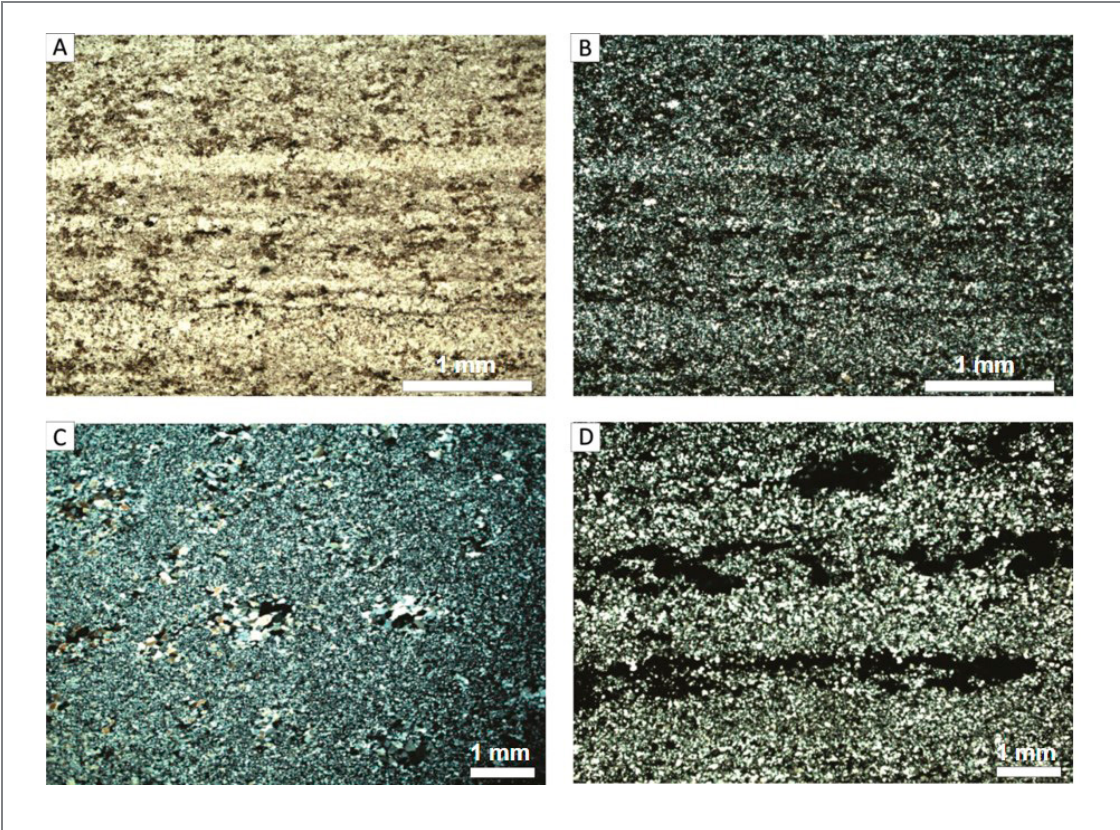
FIGURE 7 - Microscopic aspects of metachert associated with the breccias. (A) Sharply banded metachert. (B) Same image under cross-polarized light. (C) Massive metachert made up of microcrystalline quartz with patches of coarser, possibly recrystallized, quartz grains. Cross-polarized light. (D) Weakly banded metachert containing elongate cavities along the bedding suggestive of siliceous sinter. Cross-polarized